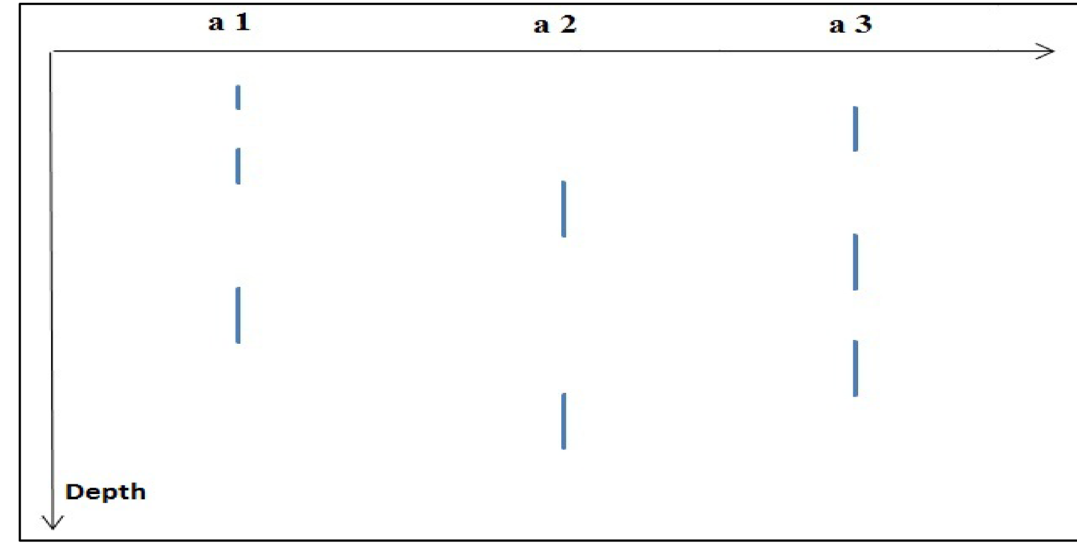
Fig. 6 Replace the average value with the real